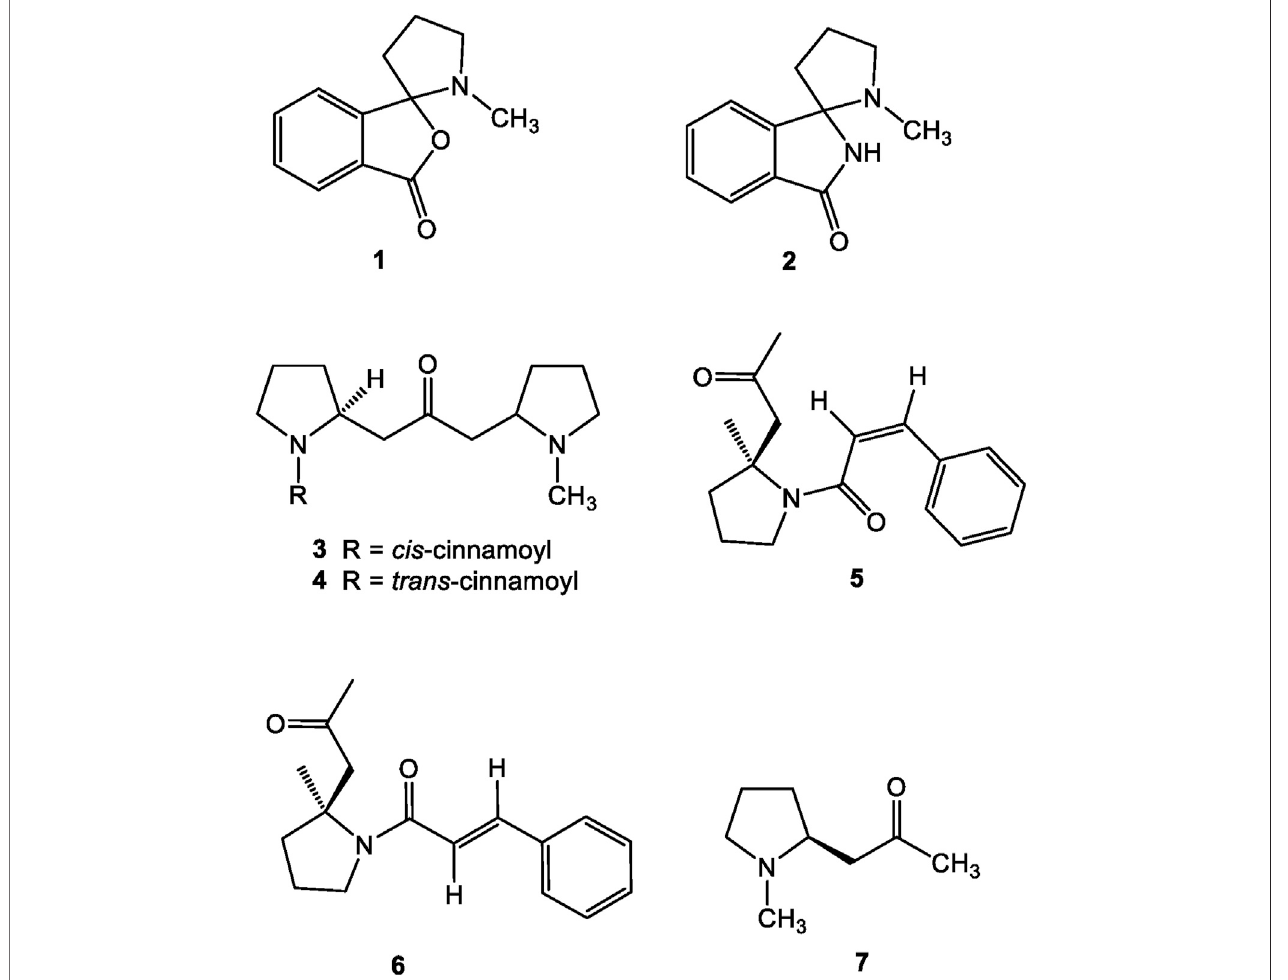
FIGURE 1 | Structures of pyrrole alkaloids reported in Dendrobium